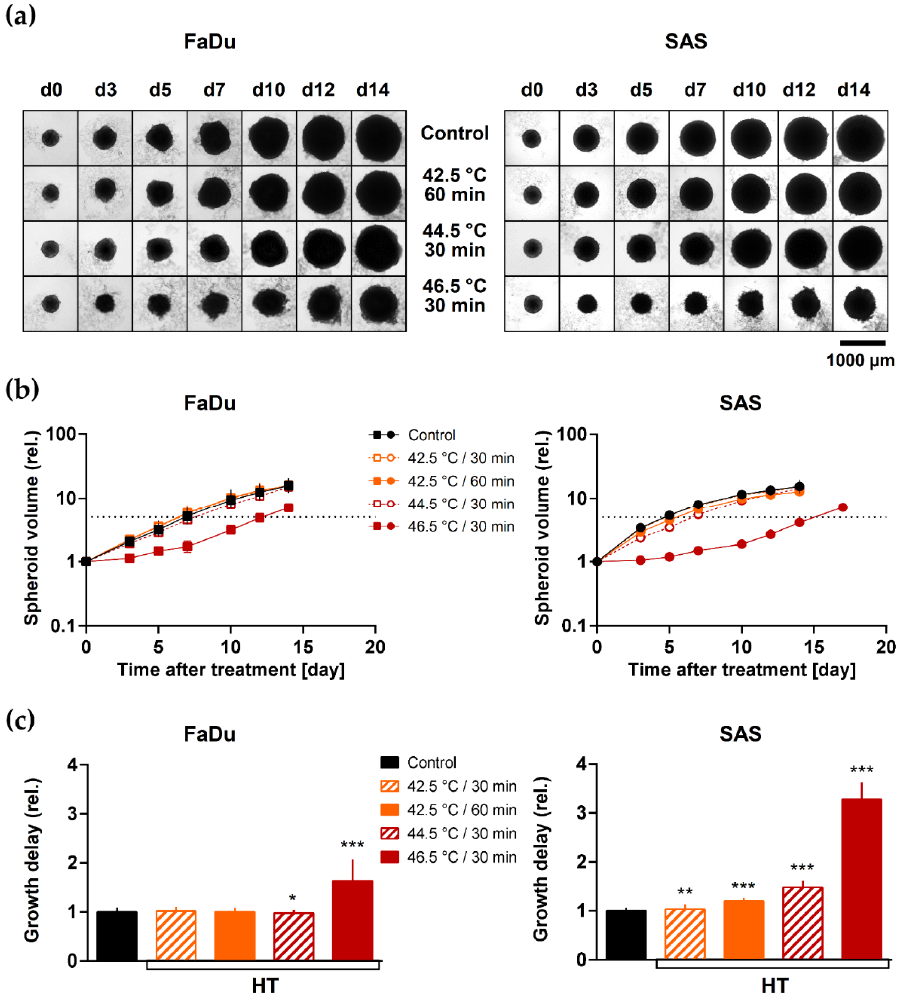
Figure 1. HT induces thermal dose-dependent HNSCC spheroid volume growth delay: ( a ) Representative image series of FaDu and SAS spheroids upon exposure to HT demonstrate the impact of various thermal doses on spheroid growth. ( b ) Effect of different hyperthermia treatments and thermal doses, respectively, on FaDu and SAS spheroid volume growth up to 14 day of post-treatment. Data show means (±SD) of ∑ n ≥ 56 spheroids per treatment arm from N = 2 independent experiments. The dotted line indicates the relative value for 5 × V 0 . ( c ) Mean relative spheroid growth delay (±SD) induced by different thermal doses calculated from the data presented in ( b ) as the extended time to reach 5× pre-treatment spheroid volume (5 × V 0 ) is shown to enable the comparison of the different spheroid types; treatment arms were normalized to the respective untreated controls. The Mann-Whitney U test was applied to estimate statistical significance of the relative growth delay (treated versus control spheroids) based on the pooled data; * p < 0.05; ** p < 0.01; *** p < 0.001.